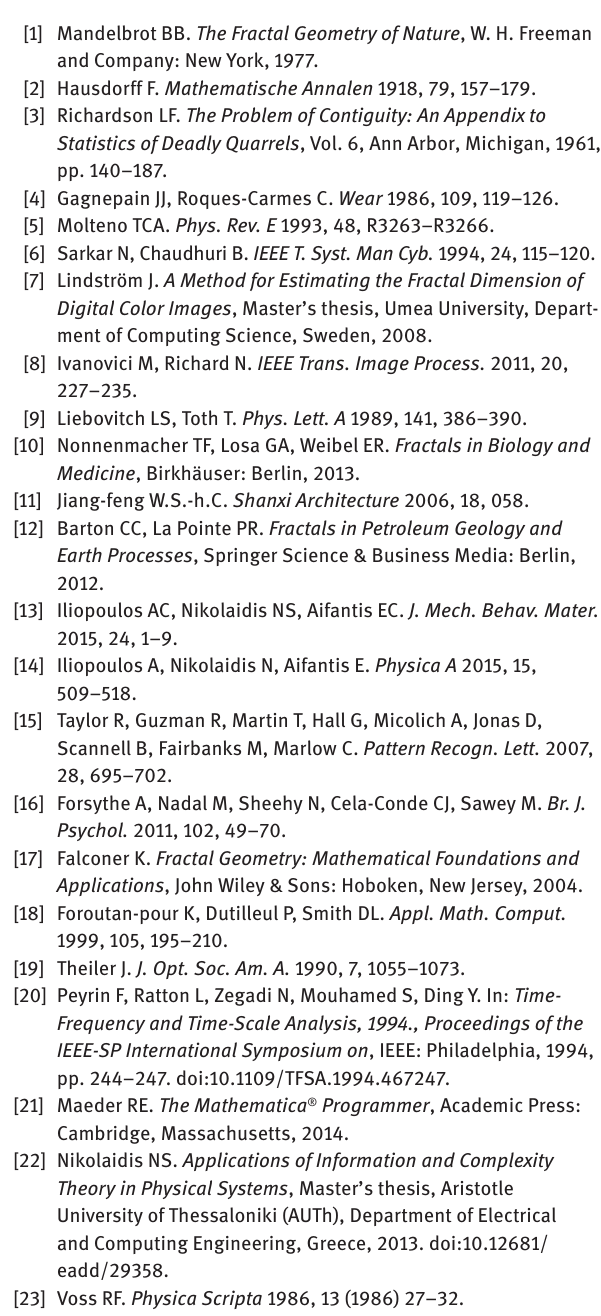
Table 2: Average computed fractal dimension for color FBS. h D th Average measured D